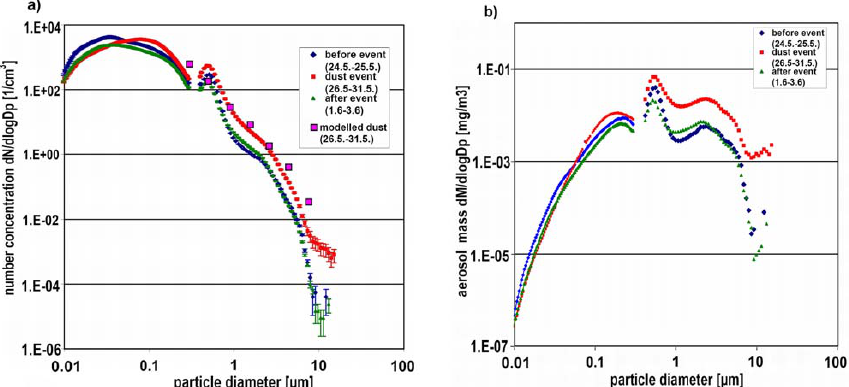
Fig. 6. Aerosol size spectra of number concentration (panel a ) and mass concentration (panel b ) measured at Taunus Observatory by scanning mobility particle sizer SMPS and aerodynamic particle sizer APS before (blue), during (red), and after (green) the dust event. Pink squares (panel a) denote the aerosol number concentration during the dust event as modelled by